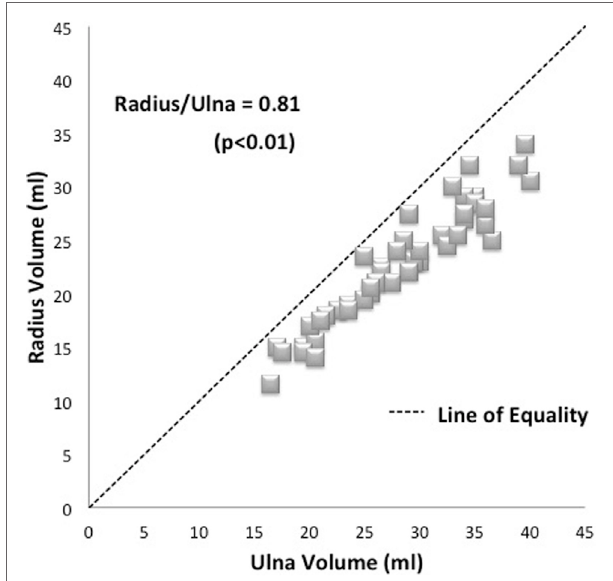
FigUre 3 | Plot of matched specimens demonstrating average radius/ulna ratio of 0.81 . Each specimen pair is represented by one dot with several pairs showing as superimposed (diamonds). The line of equality (dashed line) represents the theoretical situation where bone volumes are exactly the same as one